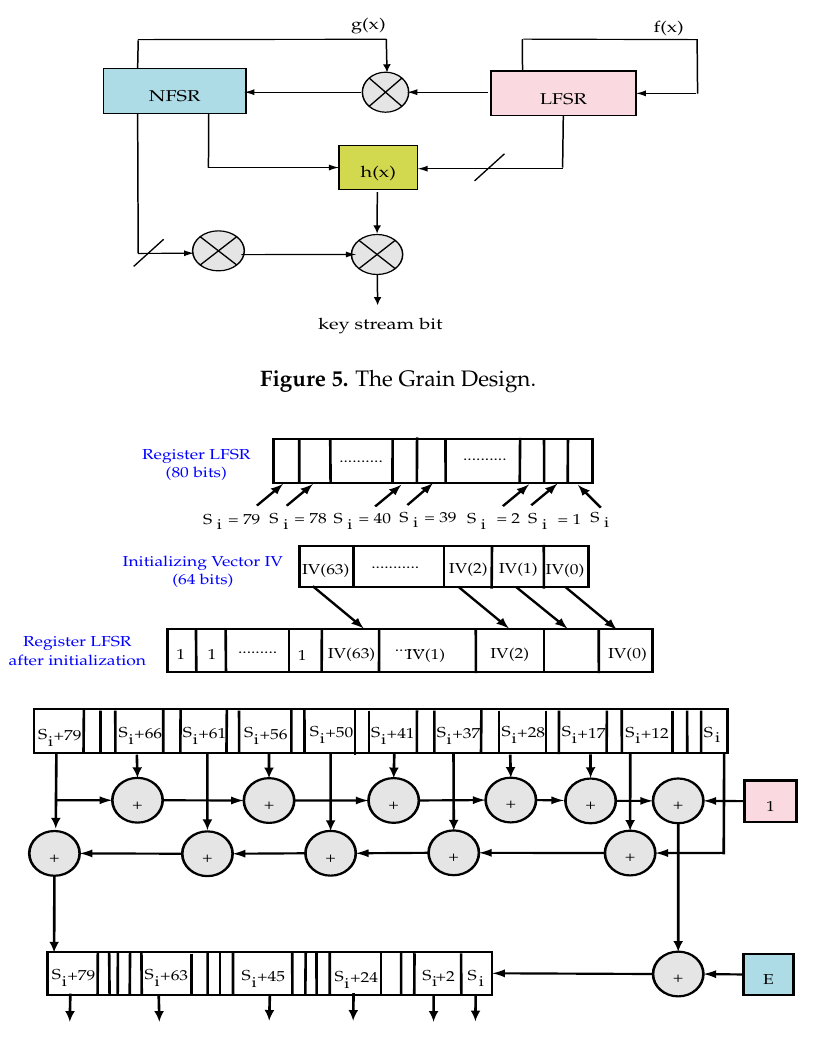
Figure 6. Linear Feedback Shift Register (LFSR) Model